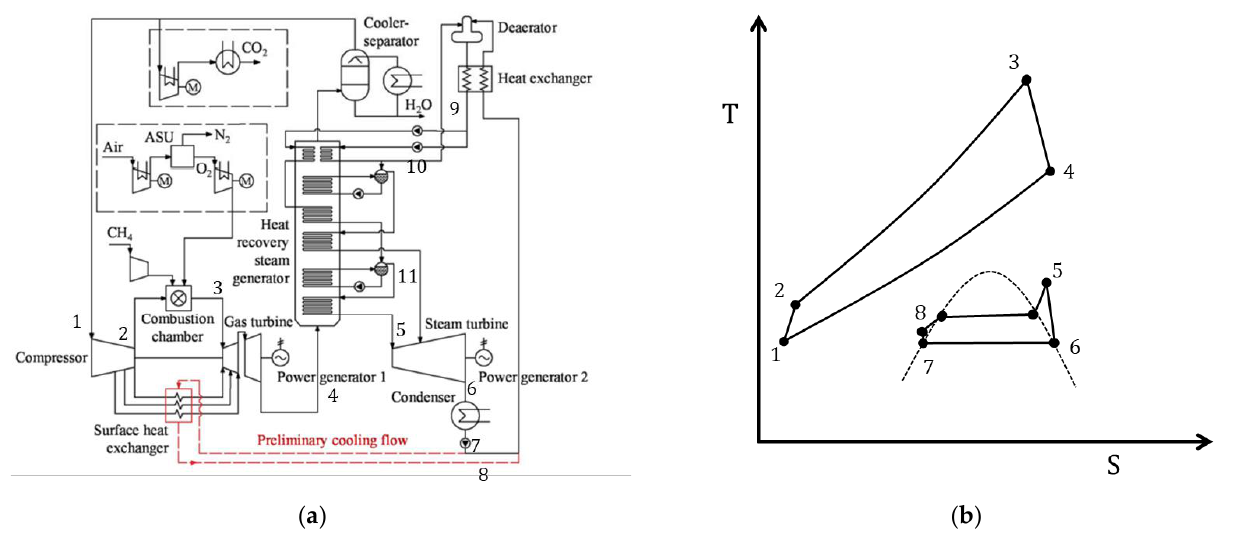
Figure 21. SCOC-CC cycle with preliminary cooling of turbine blade refrigerant: ( a ) schematic dia- gram; ( b ) T – S diagram [38]. ASU — air separation unit.